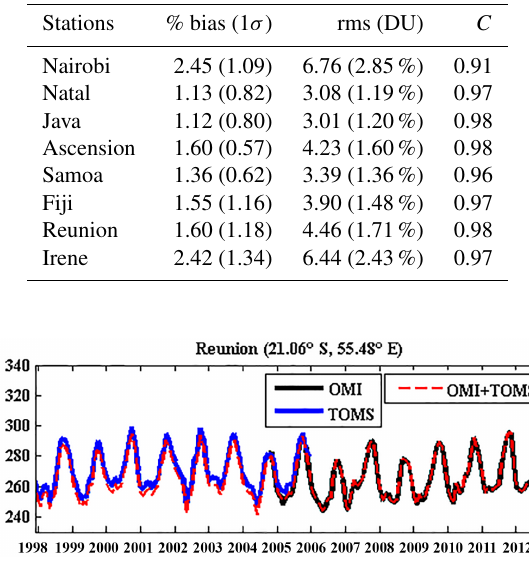
Figure 2. Monthly mean of TCO as measured by TOMS (blue) and OMI (black) over Reunion. The combined measurements of OMI and TOMS data are indicated by the dashed red line.